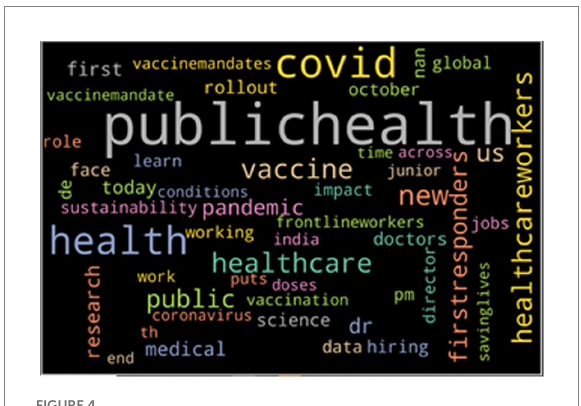
FIGURE 4 The top 50 keywords from the neutral